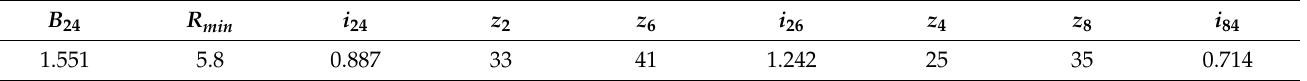
Table 2. Data for determining the ratios for gears of